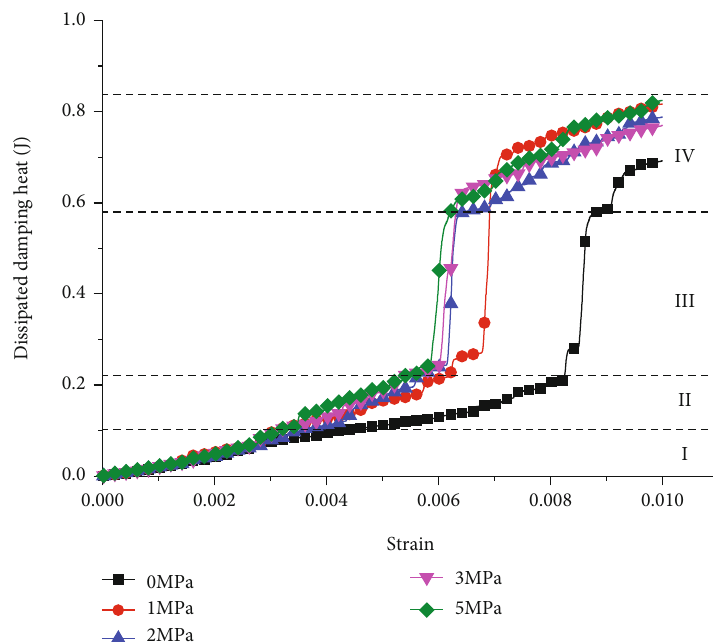
Figure 13: Changes of dissipated damping heat in the process of deformation and failure under di ff erent gas